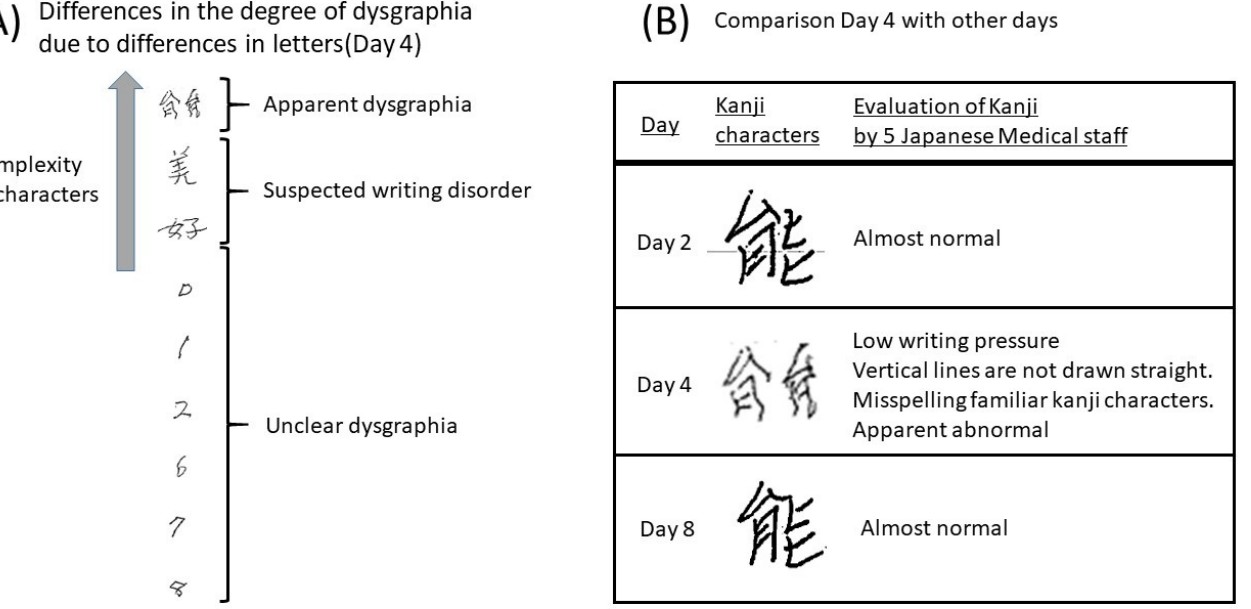
Figure 2. Characteristics of dysgraphia. ( A ) Differences in the severity of dysgraphia attributable to differences in letters. In case of complex characters, dysgraphia was evident. ( B ) Comparison with other days for letters for which dysgraphia was detected on Day 4. Based on the judgment of five medical personnel, the writing on Day 4 was deemed abnormal.